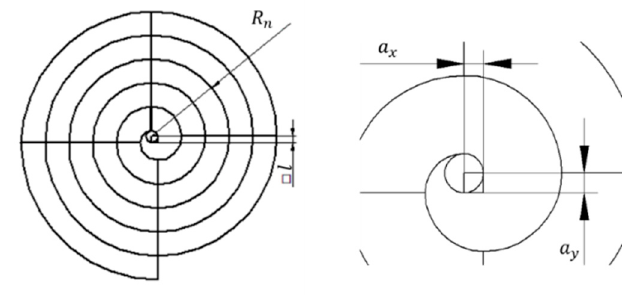
Figure 11. The spiral model.